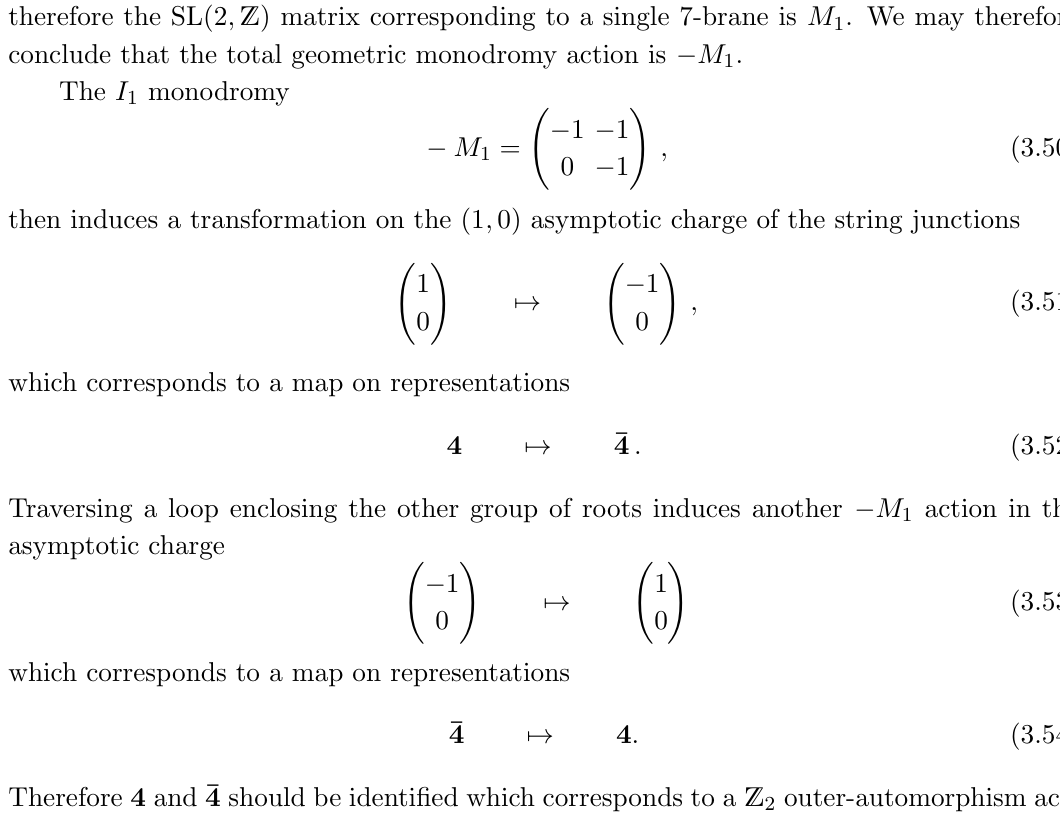
Figure 13 . The outer-automorphism acting on A 3 diagram of su (4) leads to C 2 diagram of sp (2). We recognize that [0 ; 0 ; 1] as the highest weight state of 4 and [1 ; 0 ; 0] as the highest weight state of (cid:22)4 . See appendix A.6 for further